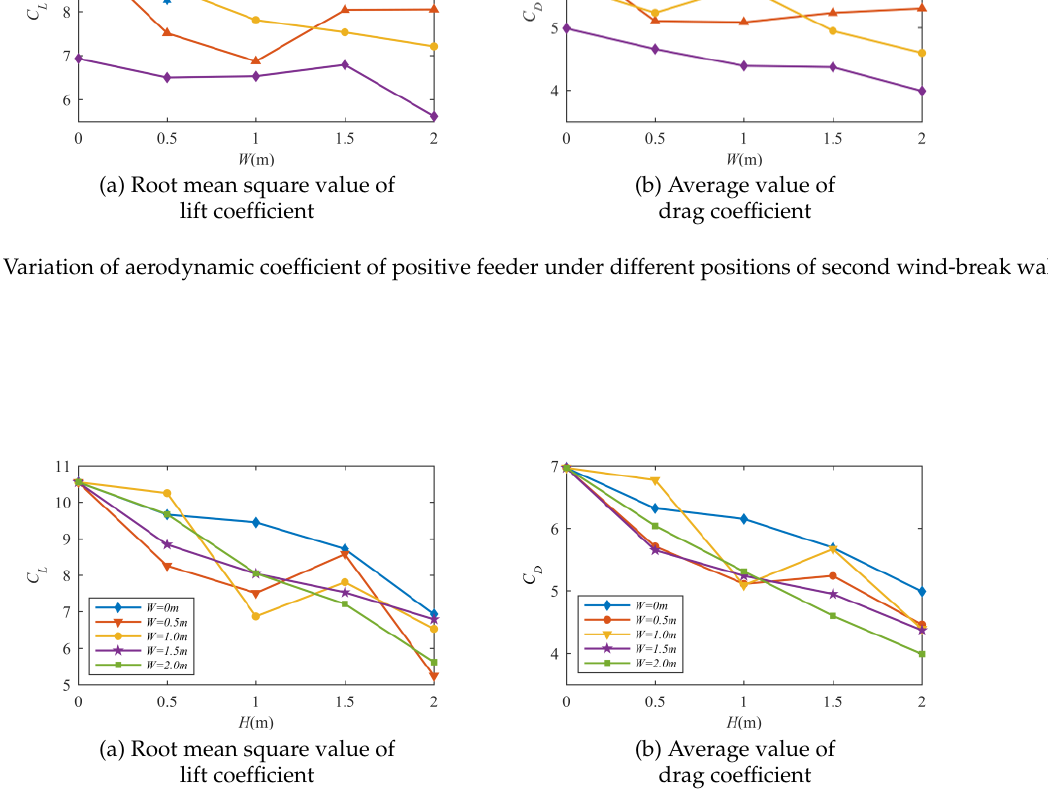
Fig. 16. Variation of aerodynamic coefficient of positive feeder under different heights of second wind-break